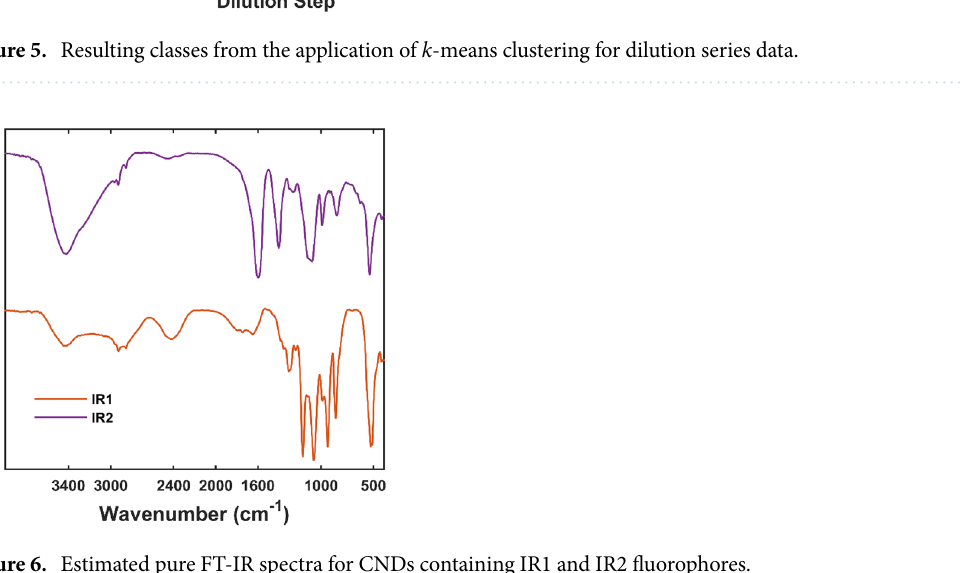
Figure 6. Estimated pure FT-IR spectra for CNDs containing IR1 and IR2